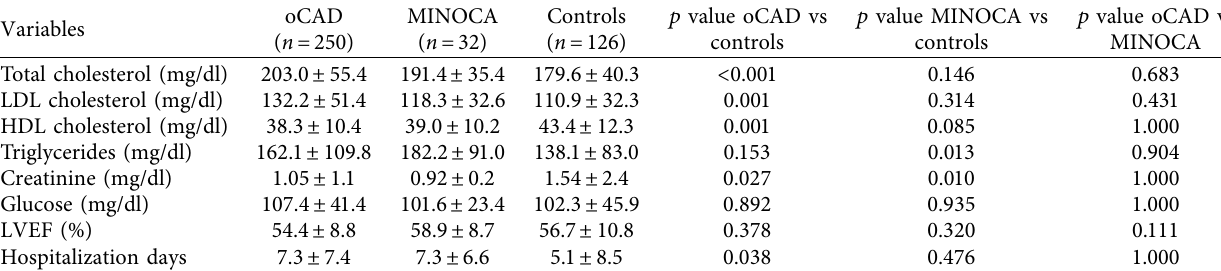
Table 2: Laboratory parameters and quantitative